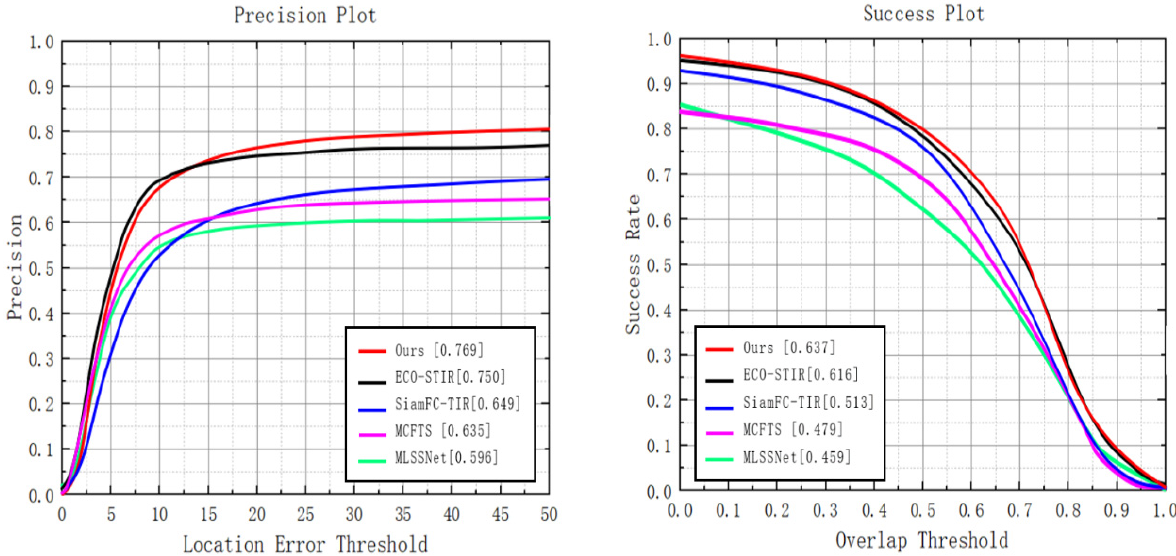
Figure 14. Comparison results with the existing methods in the LSOTB_TIR dataset.